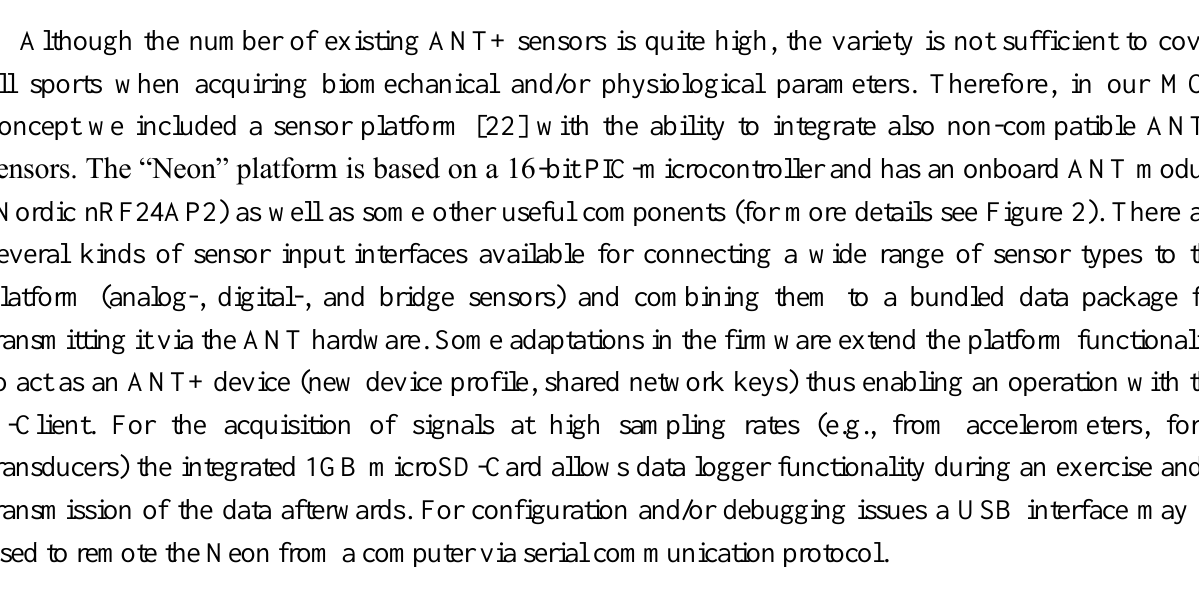
Figure 2. Systematic overview of the used sensor